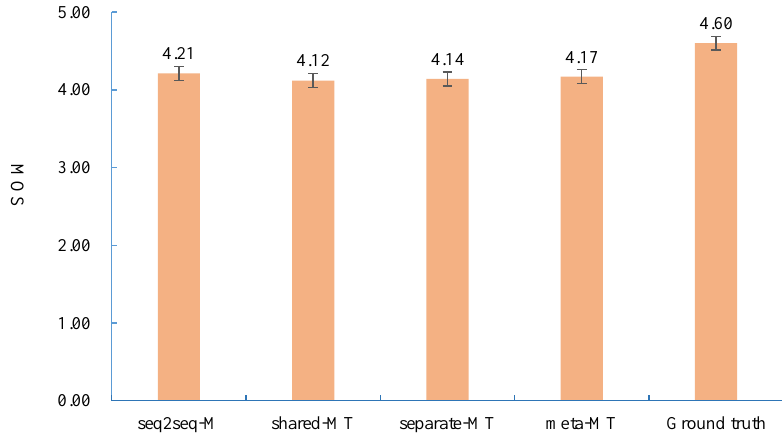
Figure 5. The average MOS scores of synthesized Mandarin speech samples under 95% confidence